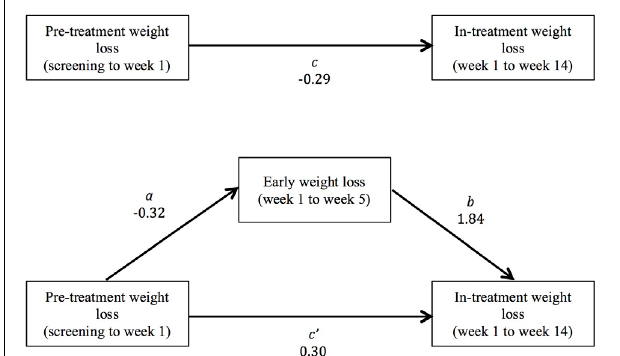
FIGURE 3 | Early weight loss from weeks 1 to 5 mediated the relationship between pre-treatment weight change and weight loss in treatment (from weeks 1 to 14). The bivariate total relationship between pre-treatment weight change and total weight loss form weeks 1 to 14 was negative and not statistically significant ( c path). The direct relationship between pre-treatment weight change and weight loss in treatment, controlling for early weight loss, was positive ( c (cid:48) path). However, pre-treatment weight change was also negatively associated with early weight loss ( a path), and early weight loss was a positive predictor of total in-treatment weight loss ( b path). Therefore, the indirect effect of pre-treatment weight change on total weight loss was negative ( ab